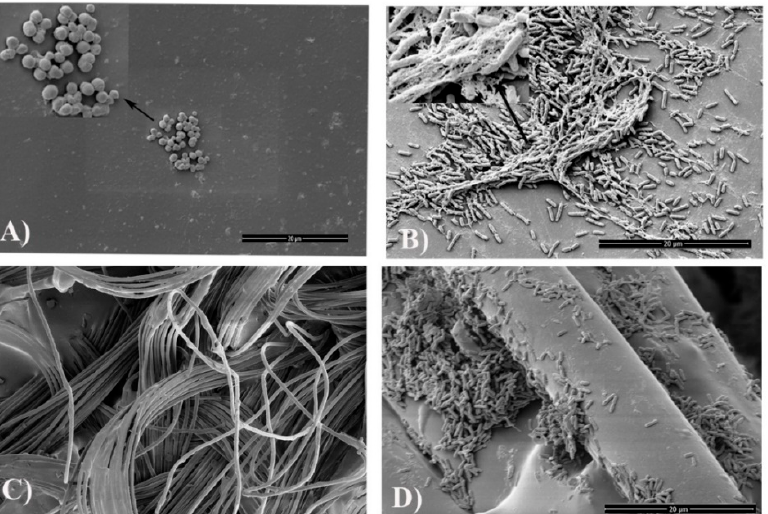
Figure 3. In vitro biofilm formation on different components of a VAD driveline [9]. ( A ) Biofilms formed by S. aureus ATCC 25923 on the smooth section of the driveline; ( B ) Biofilm formation of P. aeruginosa PAO1 on the smooth section of the driveline; ( C ) Three-dimensional structure of the driveline velour; ( D ) Biofilm formation of P. aeruginosa PAO1 on the velour section. Drip flow biofilm reactor assay was used to mimic the clinical environment where an implanted driveline and invading microorganisms might encounter. Reprinted from Reference [9], Copyright (2020), with permission from Elsevier.